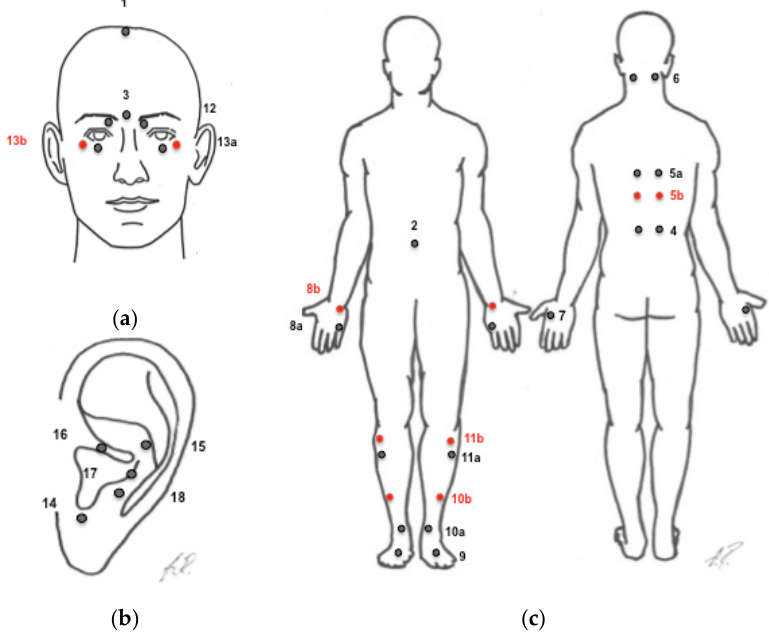
Figure 1. Needle acupuncture of the body and the ears was performed following standardized protocol (Table 1). The approximate location of the needles on the face and the ears are presented on ( a , b ); and on the body ‐ on ( c ). The needles at LI ‐ 4 (He Gu), CV ‐ 6 (Qi Hai), LV ‐ 3 (Tai Chong), and all ear needles were manually stimulated once in each session after 15 min (+/ ‐ 5 min). Treatment 1 (labelled in black) alternated with treatment 2 (labelled in red, see also in Table 1).